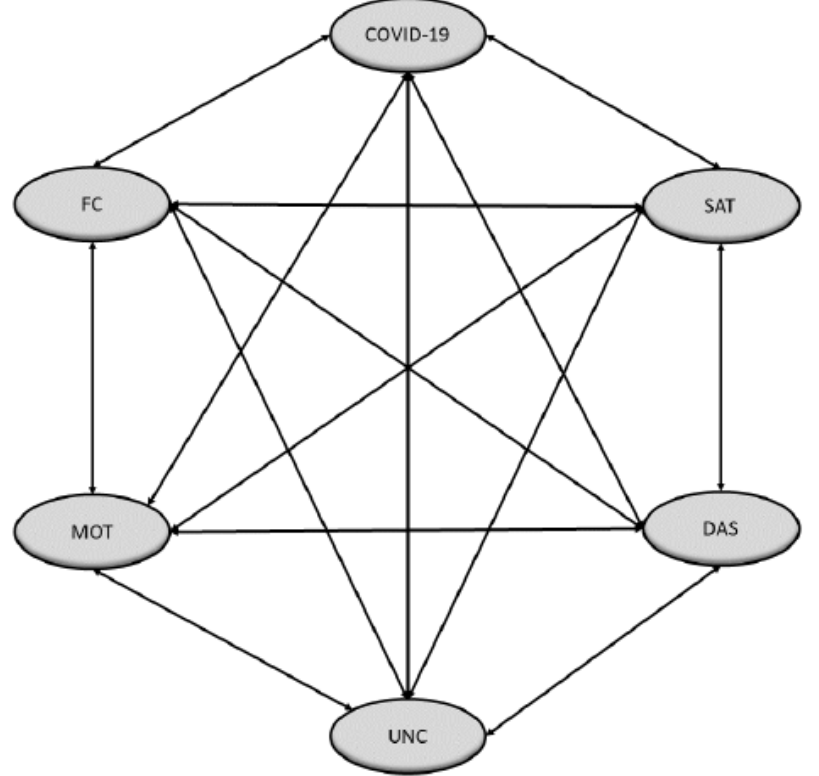
Figure 1. Theoretical model to determine the level of dependence between latent variables. Note: Own production.